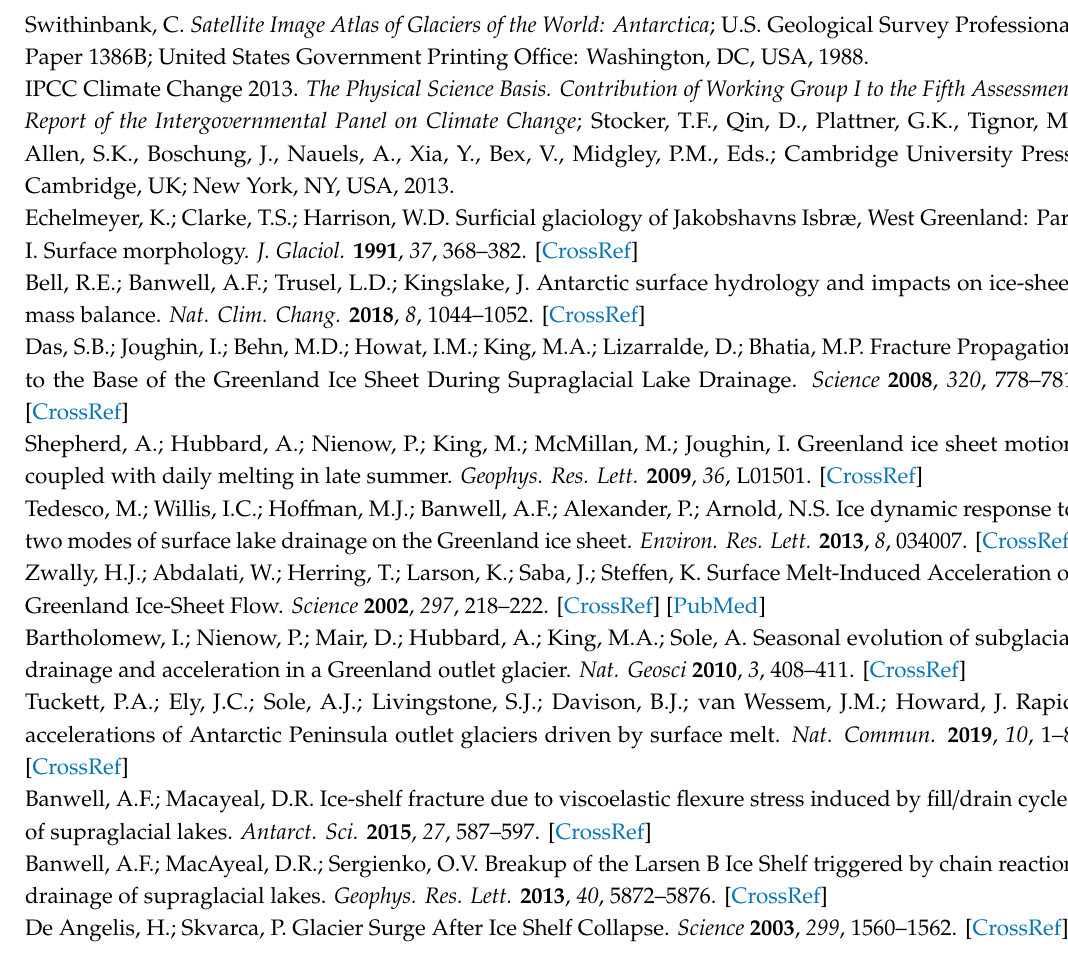
Figure S1: Distribution of sampling points within the test scenes of (a) Nivlisen Ice Shelf, (b) Amundsen Bay, (c) Wilhelm II Coast, (d) Drygalski Ice Tongue, (e) Hull Glacier, (f) Abbott Ice Shelf (g) Cosgrove Ice Shelf and (h) George VI Ice Shelf. Table S1: Sentinel-2 test data covering the 2017, 2018, 2019 and 2020 melt seasons over Amery Ice Shelf. Table S2: List of acronyms introduced throughout the